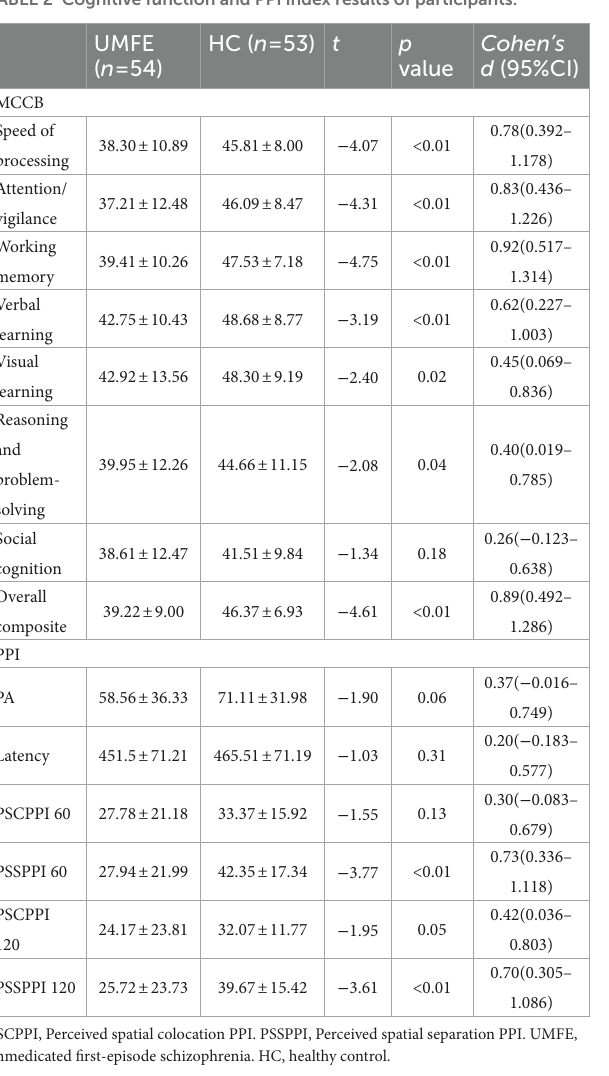
TABLE 2 Cognitive function and PPI index results of